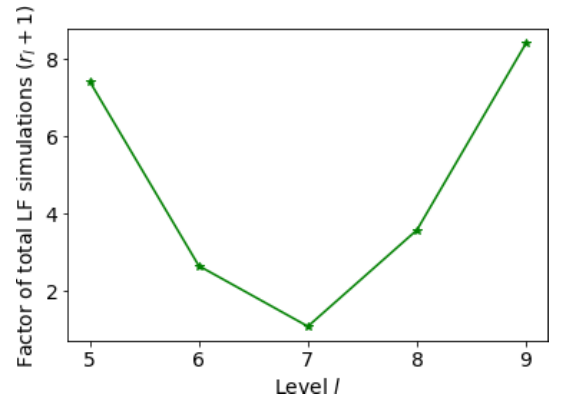
Figure 18. Factor of total LF simulations ( r l + 1) required by MLMF compared to number of HF simulations for the Carrier–Greenspan test case, where r l is Eq. (13).